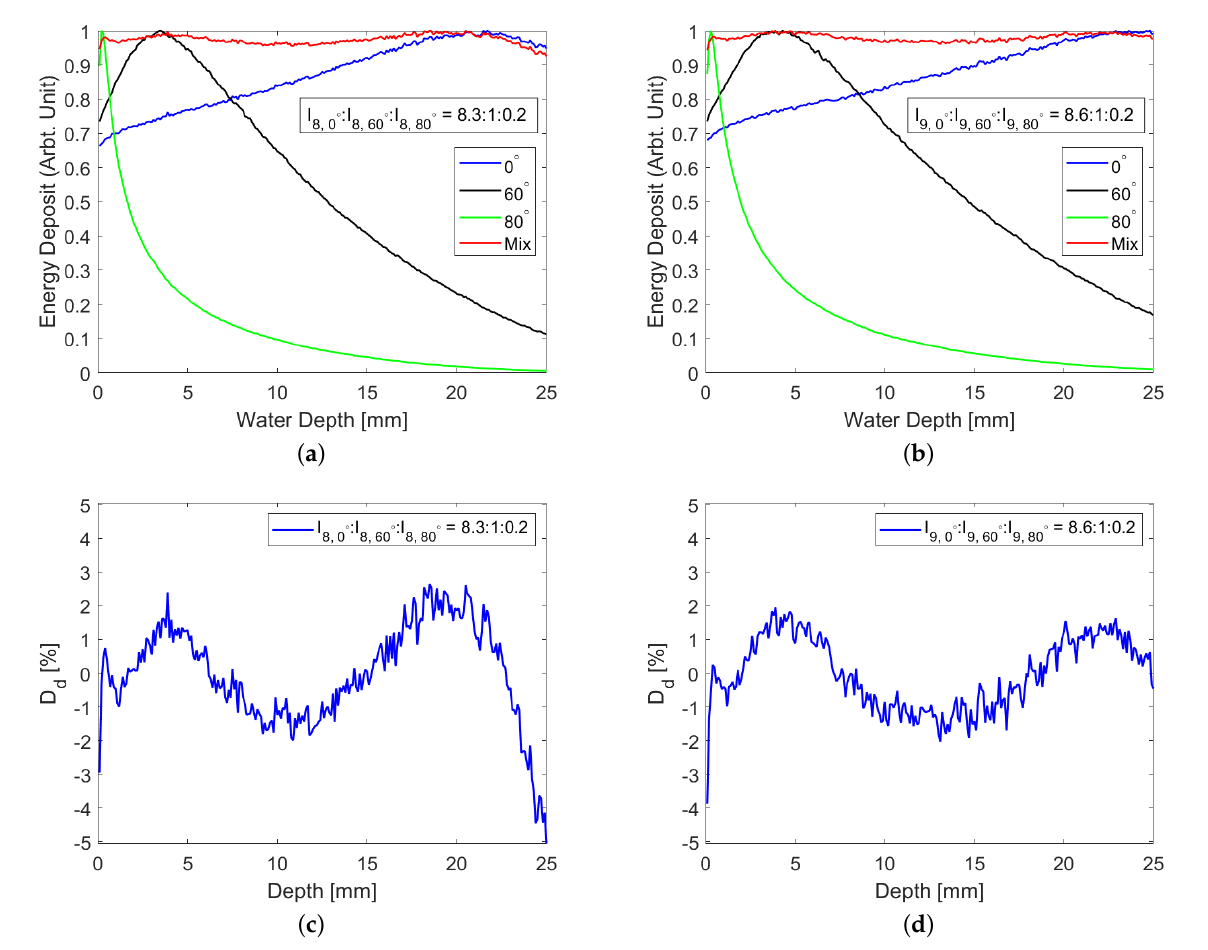
Figure 15. Single-sided irradiation by combining beams with different angles of incidence for ( a ) 8 MeV and ( b ) 9 MeV beams. Dose deviation for ( c ) 8 MeV and ( d ) 9 MeV beams. I is the beam intensity as given in Equation